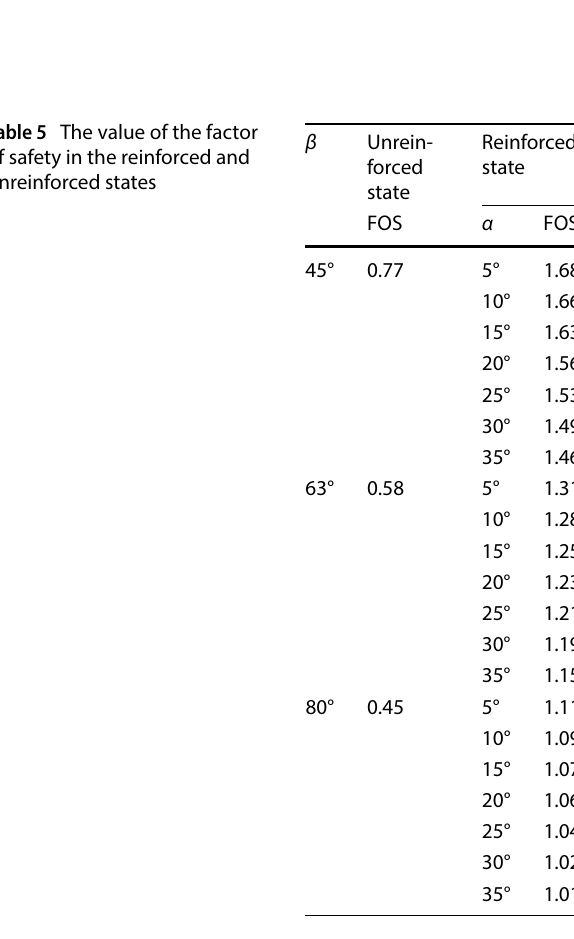
Fig. 4 The failure circles in the different angles of the slope before nailing